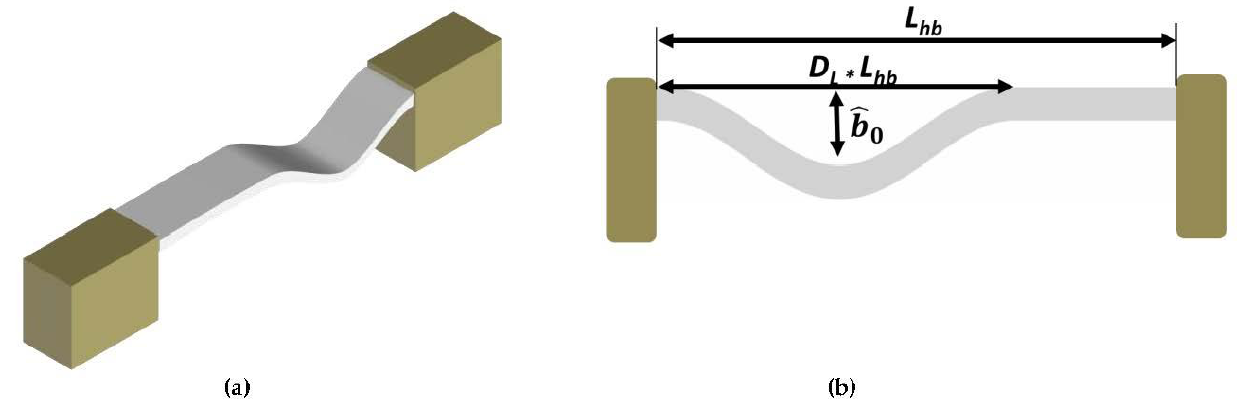
Figure 1. ( a , b ) 3D and 2D schematic of the in-plane clamped-clamped- hybrid beam resonator, respectively.